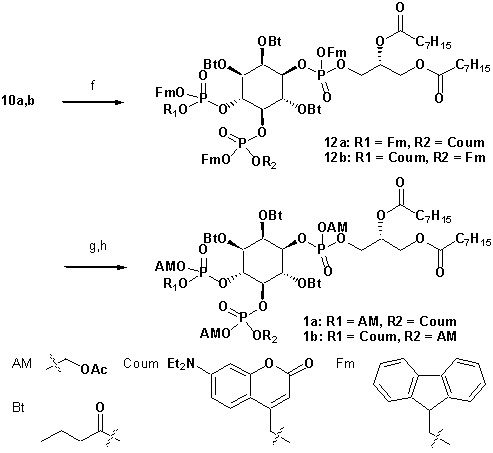
Synthesis of 1a,b.